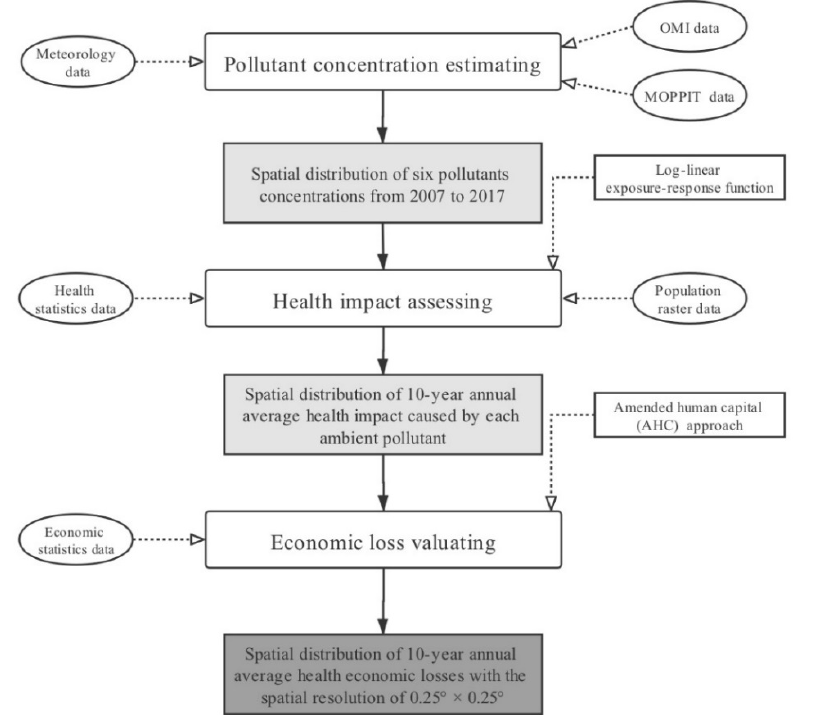
Figure 1. Flow chart of spatial assessment of health economic losses.